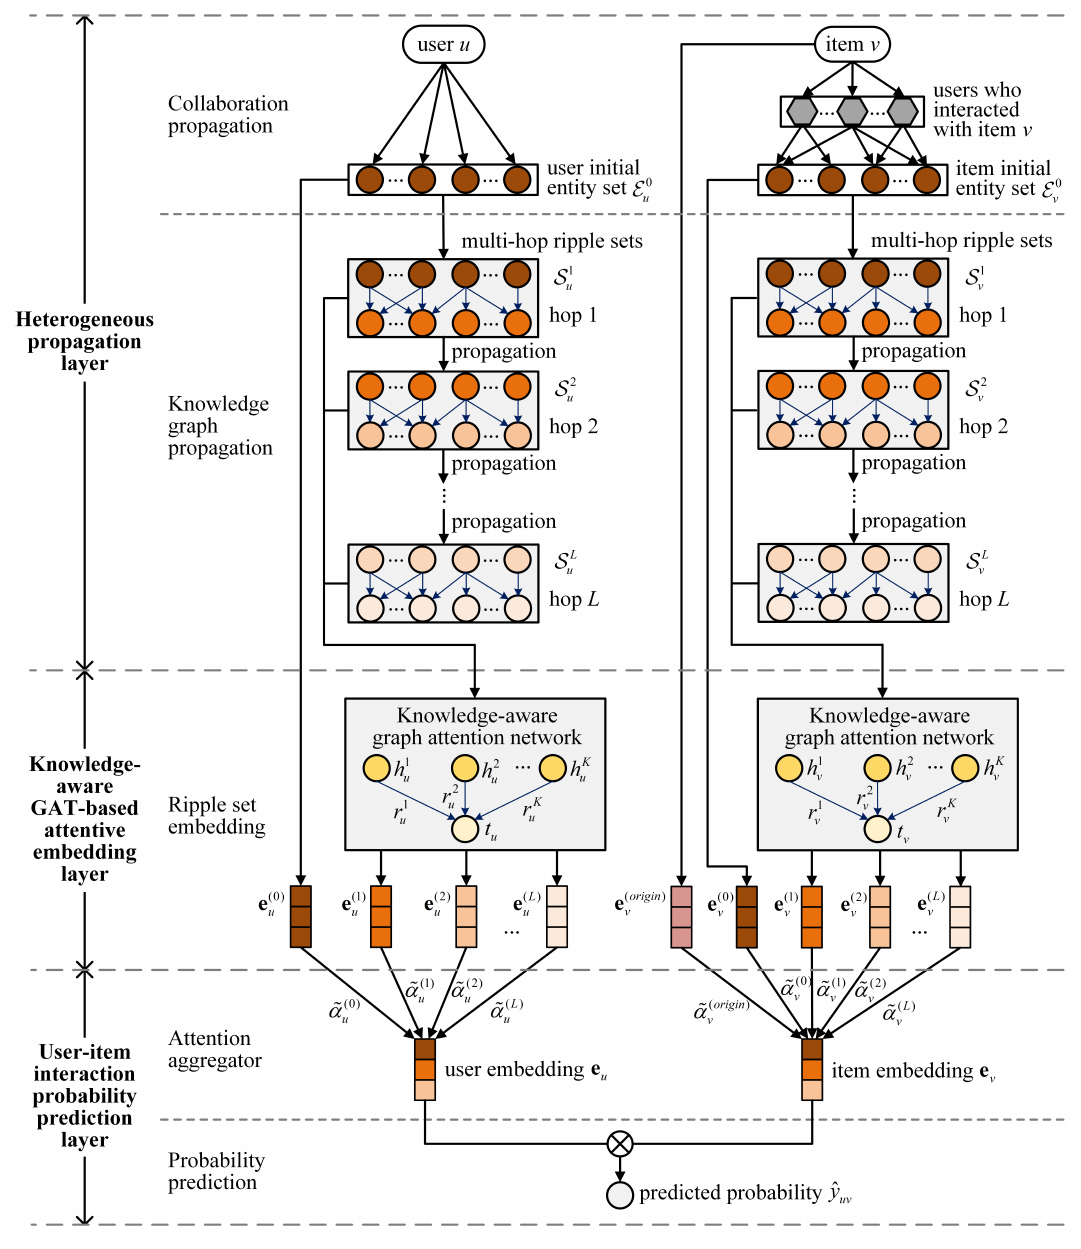
Figure 1. The overall framework of